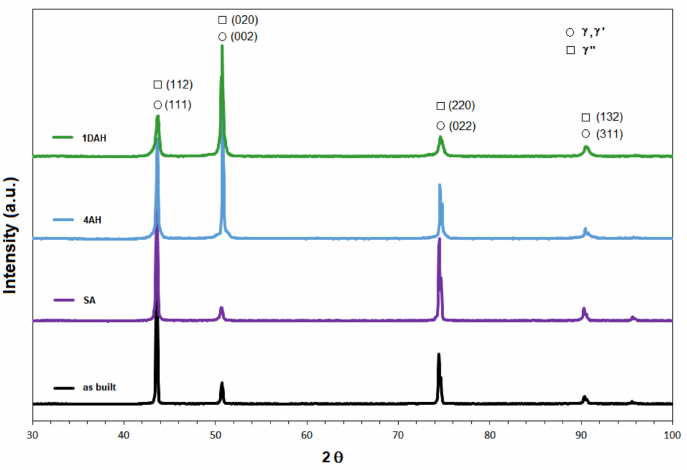
Figure 15. XRD patterns of the micro-LPBF Inc 718 samples before and after heat treatment.